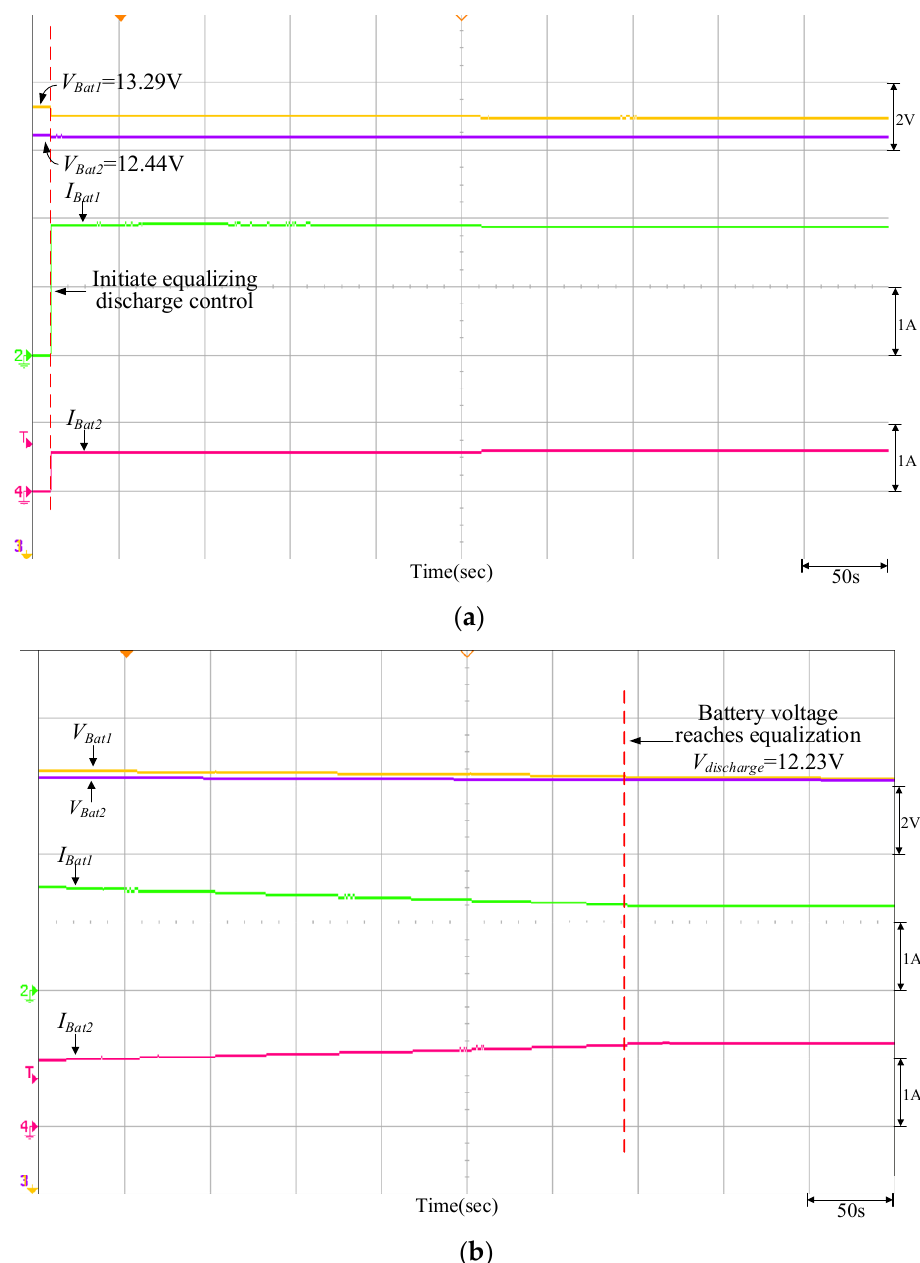
Figure 20. Equalizing discharge control response of the traditional P-I controller when V Bat1 = 13.29 V and V Bat2 = 12.44 V: ( a ) initiate equalizing discharge control; ( b ) reach equalizing discharge equalization.